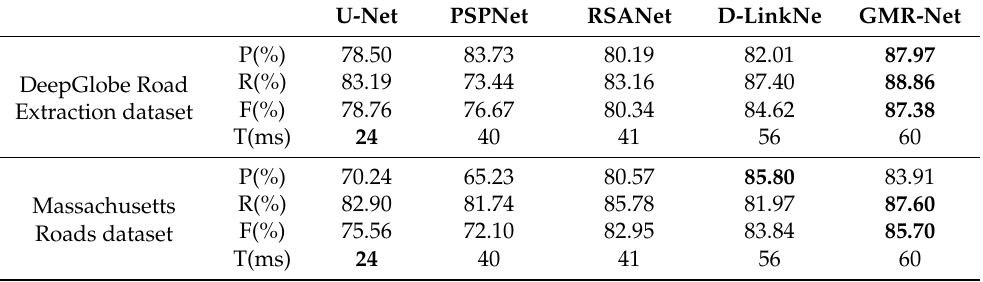
Figure 10. A comparison of classification results on the Massachusetts Roads dataset. ( a ) Input images; ( b ) ground truth; ( c ) U-Net; ( d ) PSPNet; ( e ) RSANet; ( f ) D-Linknet; and ( g ) GMR-Net. The red-dashed frame shows the area where the judgement is missing and the yellow-dashed frame is the false judgment area. Table 8. Using DeepGlobe Road-Extraction and Massachusetts Road datasets, the results of the GMR-Net method are compared with other methods, in which the values shown in bold are best.